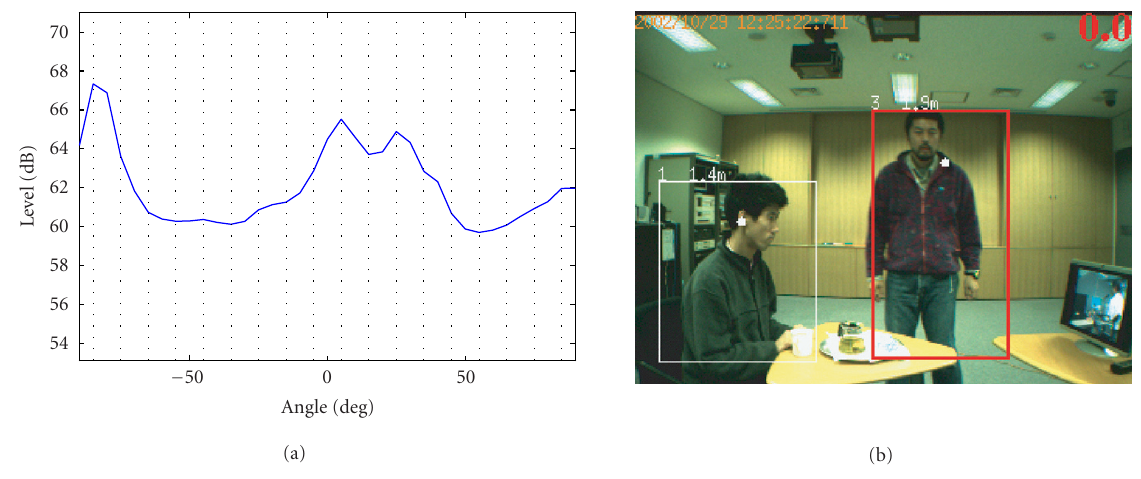
Figure 1: Example of (a) the audio information (spatial spectrum) and (b) the video information (human